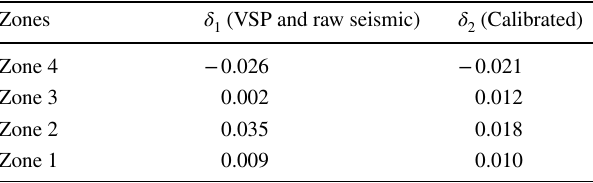
Table 4 Thomsen’s anisotropy parameter delta ( δ using VSP and seismic raw and calibrated PSDM velocities, respec- tively